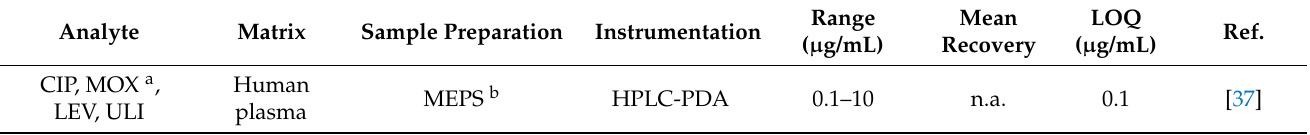
Table 2. Comparison of the proposed method with methods present in